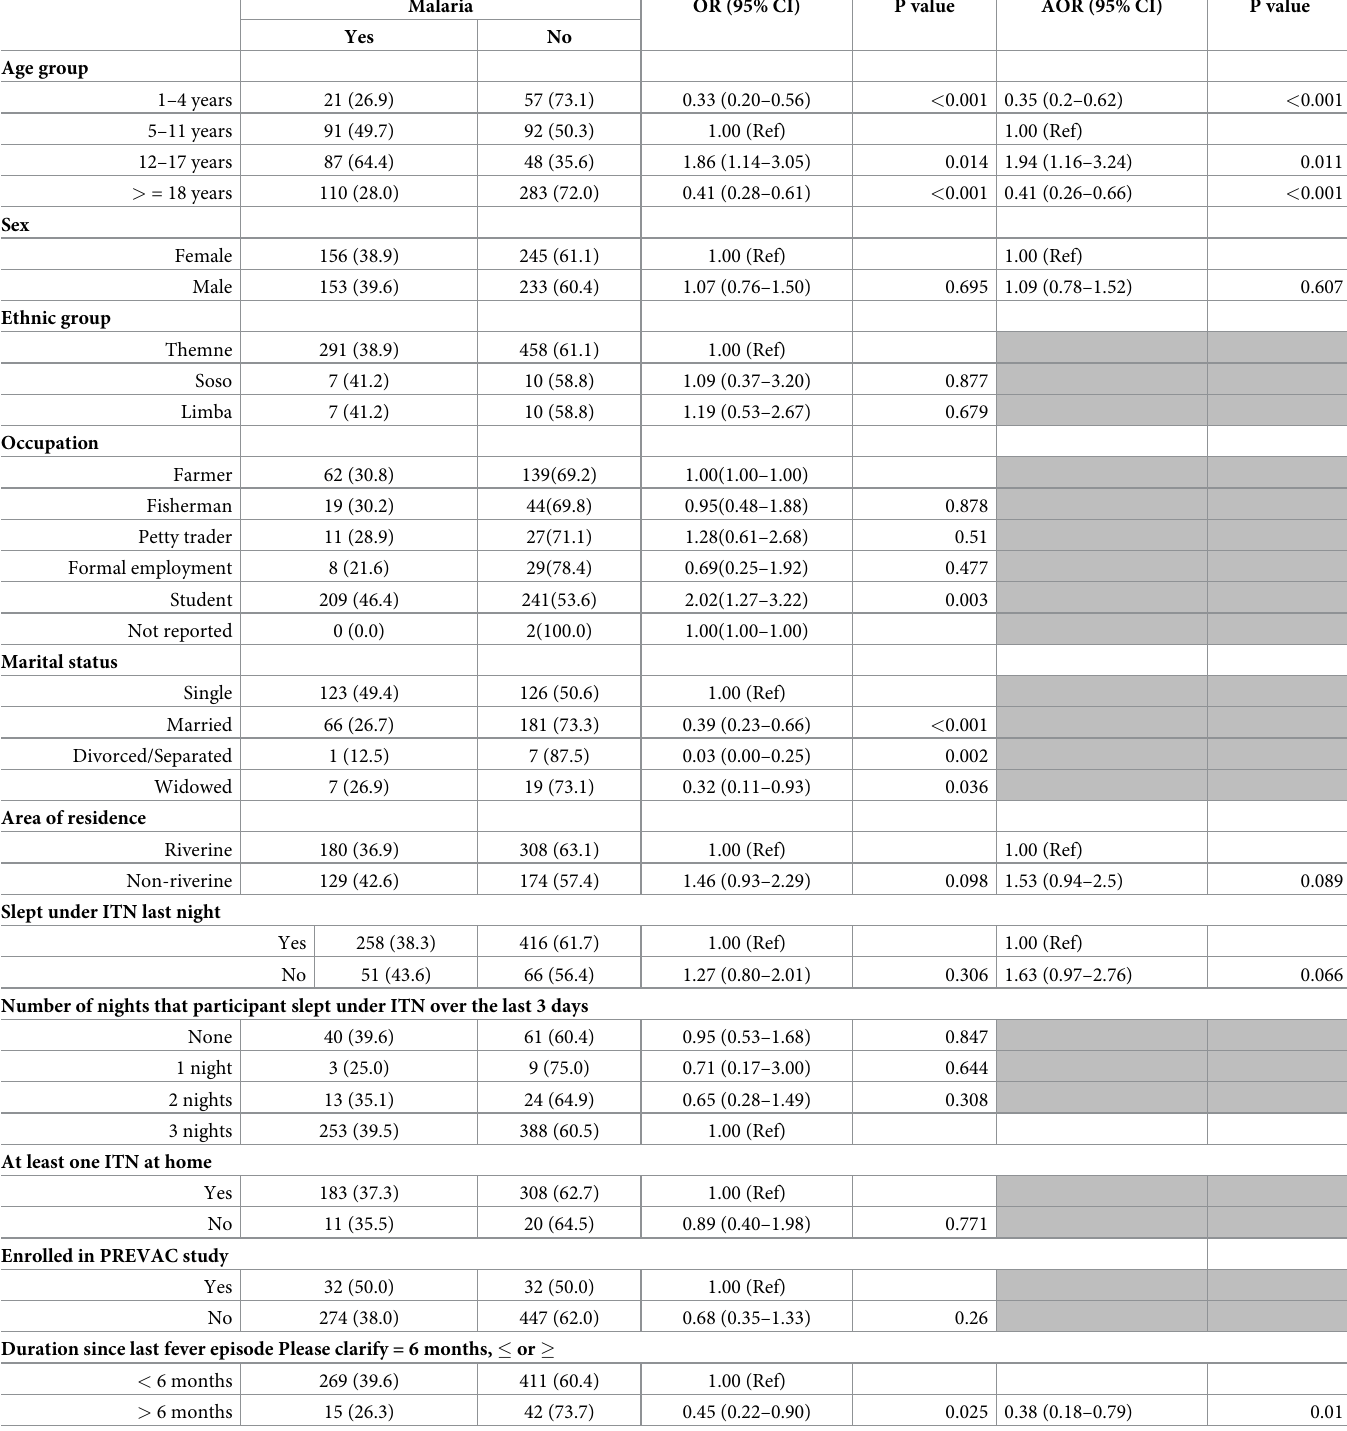
Table 3. Risk factors for malaria infection among participants in Mambolo